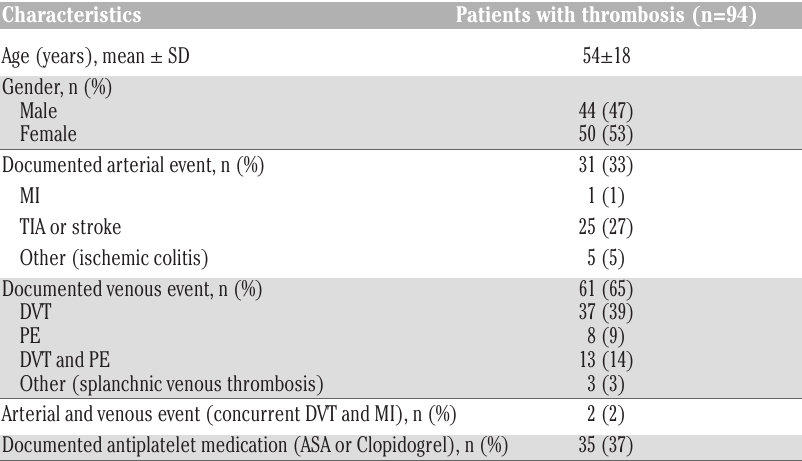
Table 1. Characteristics of patients with thrombosis.